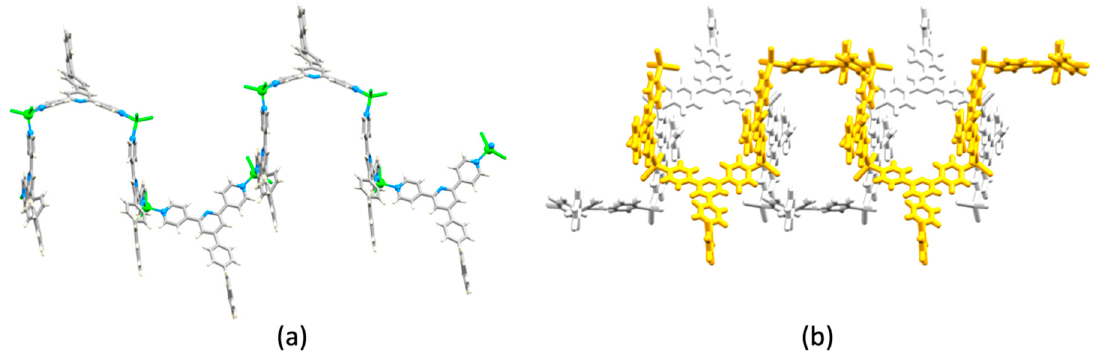
Figure 12. ( a ) Part of one chain of [Zn( 22 )Cl 2 ] n (CSD refcode QOJBOI) showing the crenelated profile. ( b ) Adjacent chains in [Zn( 23 )Cl 2 ] n are related by inversion (refcode QOJBAU).